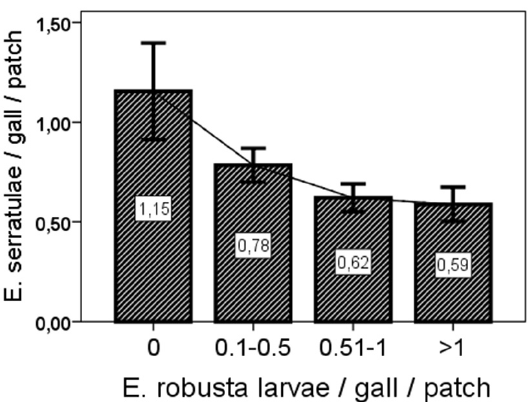
Figure 7. Average numbers of E. serratulae larvae / gall in U. cardui populations with different parasitization rates of E. robusta. (Sample sizes: 227, 332, 295, 209 gall